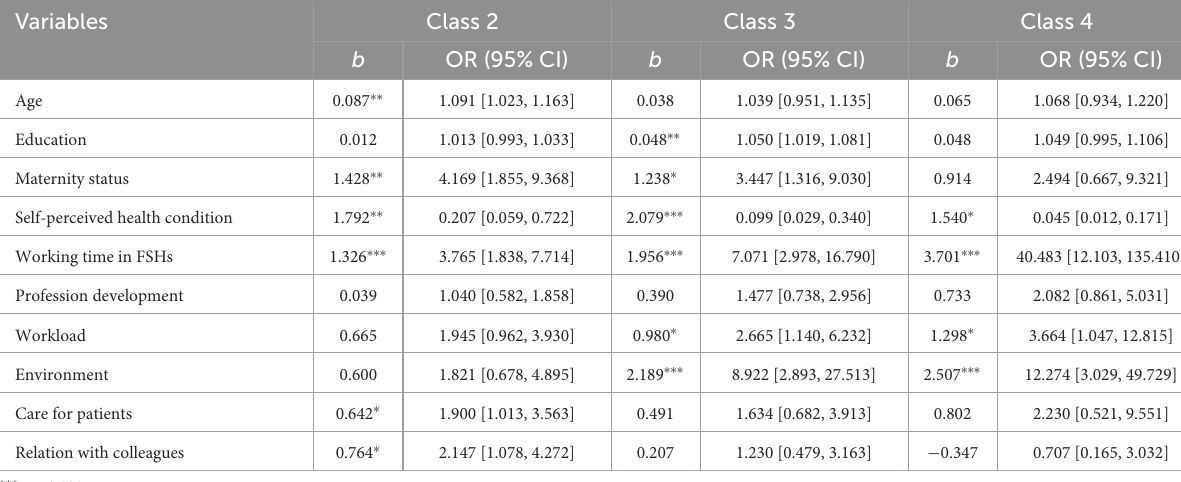
TABLE 4 Multinomial logistic regression on stress load classes ( n =